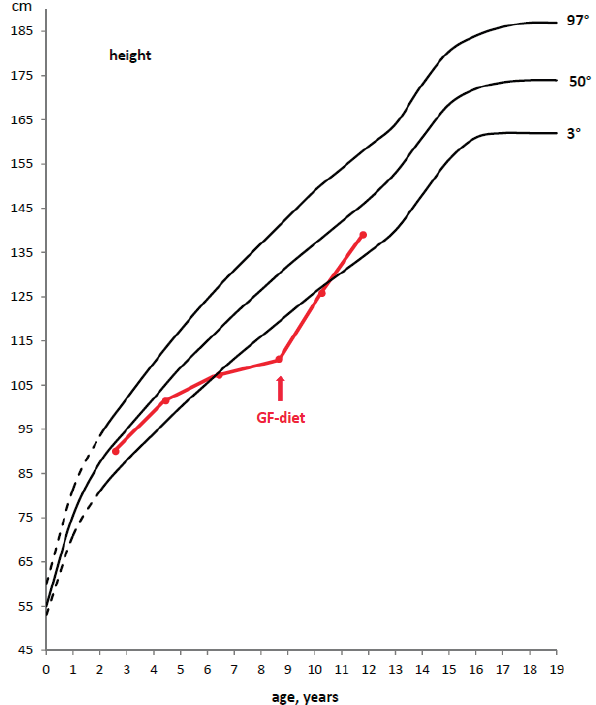
Figure 2. Example of a deceleration of growth rate in a CD child and catch-up growth after the introduction of a